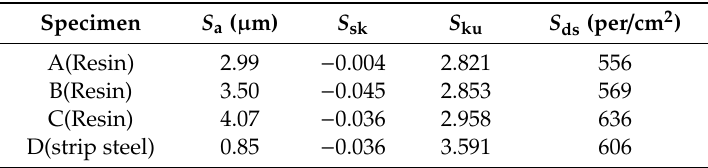
Table 2. The roughness parameters of roll and initial